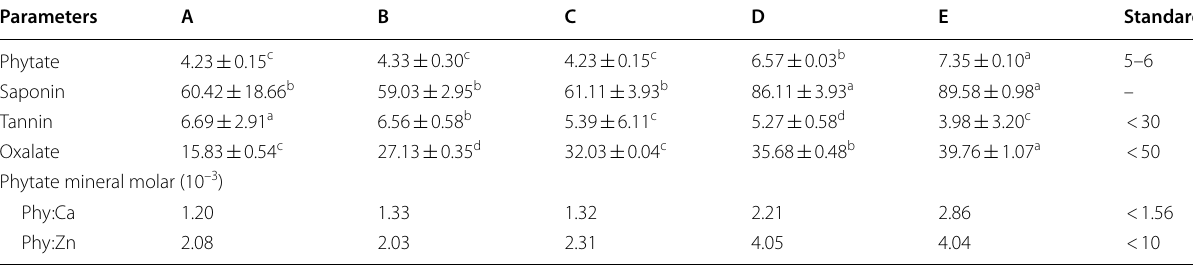
Mean standard deviation for three determinations. Values with different superscripts on a row are significantly different at p < 0.05 ± CSF: corn silk flour; LF: lemon flour; A: 100% CSF; B: 95% CSF and 5% LF; C: 90% CSF and 10% LF; D: 85% CSF and 15% LF; E: 80% CSF and 20%